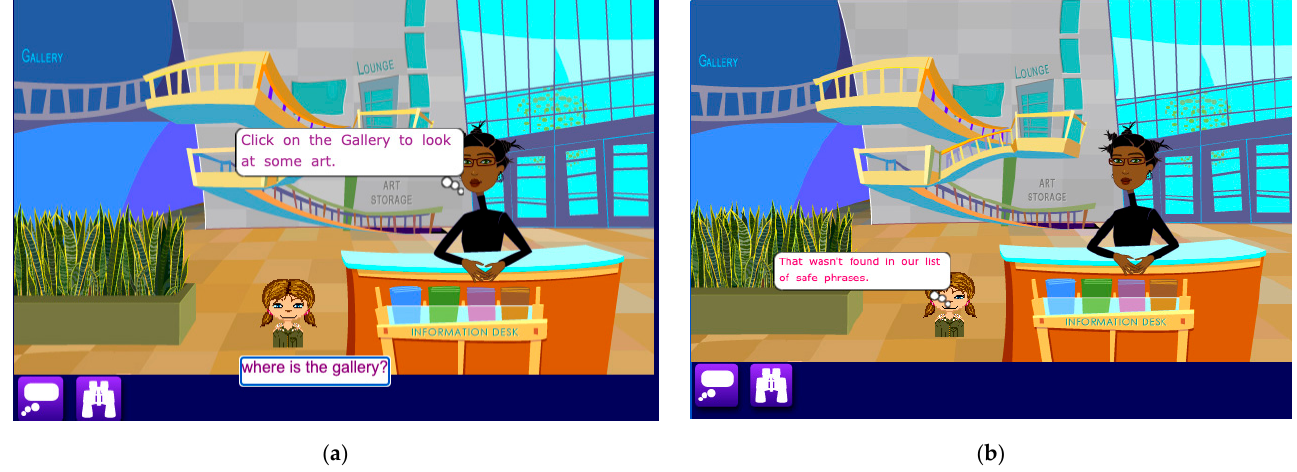
Figure 4. ( a ) An in-game character at the information desk suggests in response with a message that reads, “Click on the Gallery to look at some art.” In response, a player (the first author) asks an open-ended question “Where is the Gallery” in Whyville ; ( b ) a system-generated response to the player’s question “Where is the gallery?” The chat bubble in the restricted chat mode in Whyville reads “That wasn’t found in our list of safe phrases”.